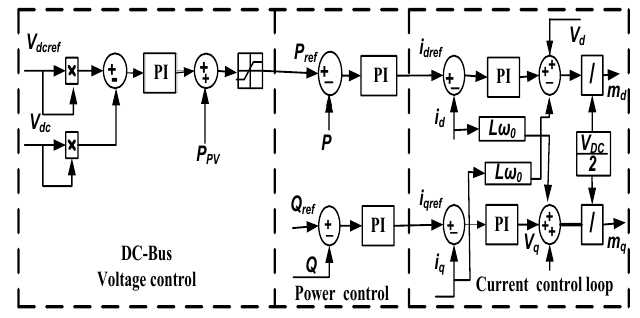
Fig.3. Active-reactive power